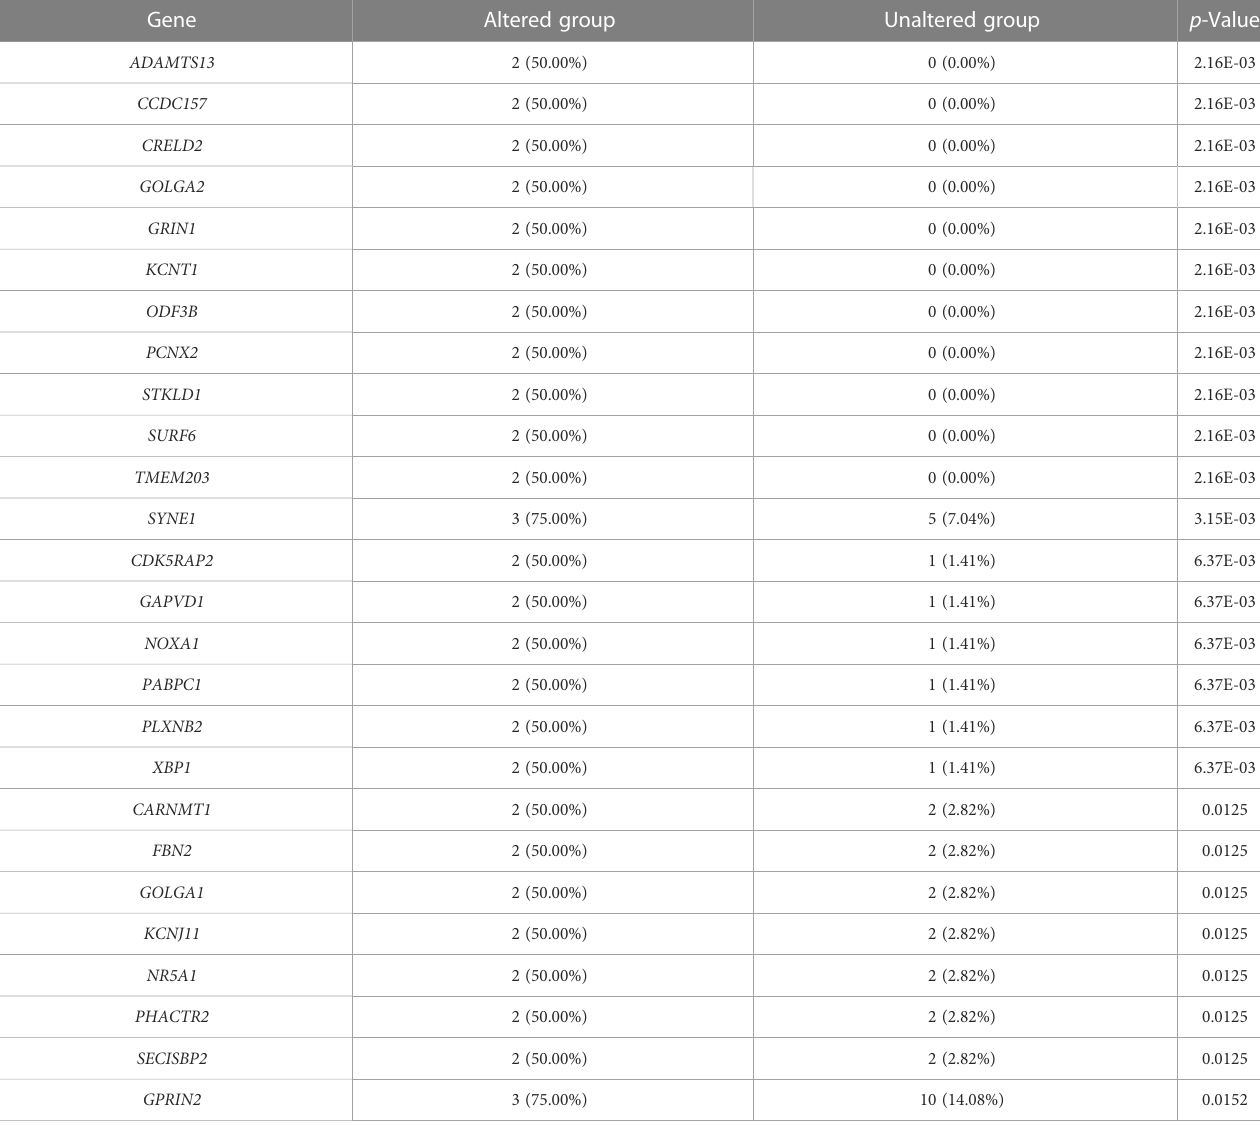
TABLE 2 The top 50 of BRD3 neighbor gene alterations in ACC